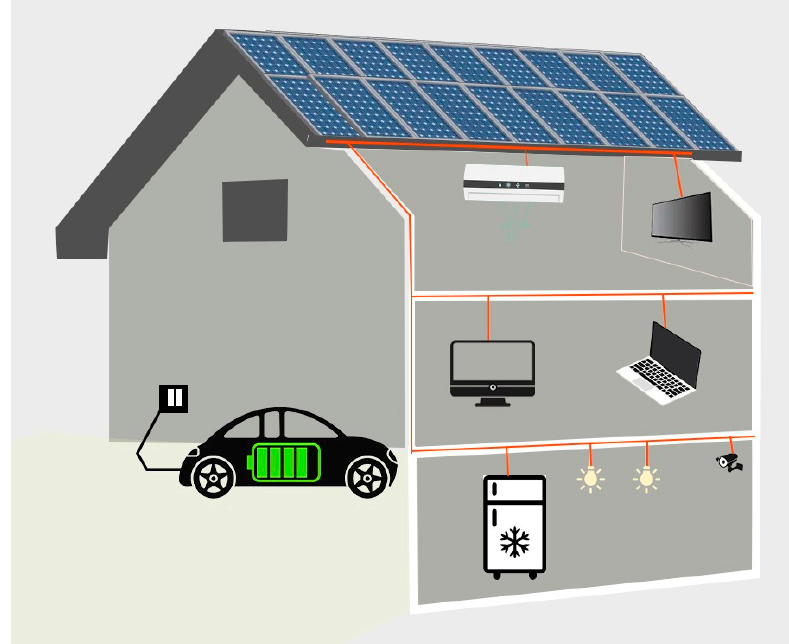
Figure 1. Solar energy applications in home appliances.